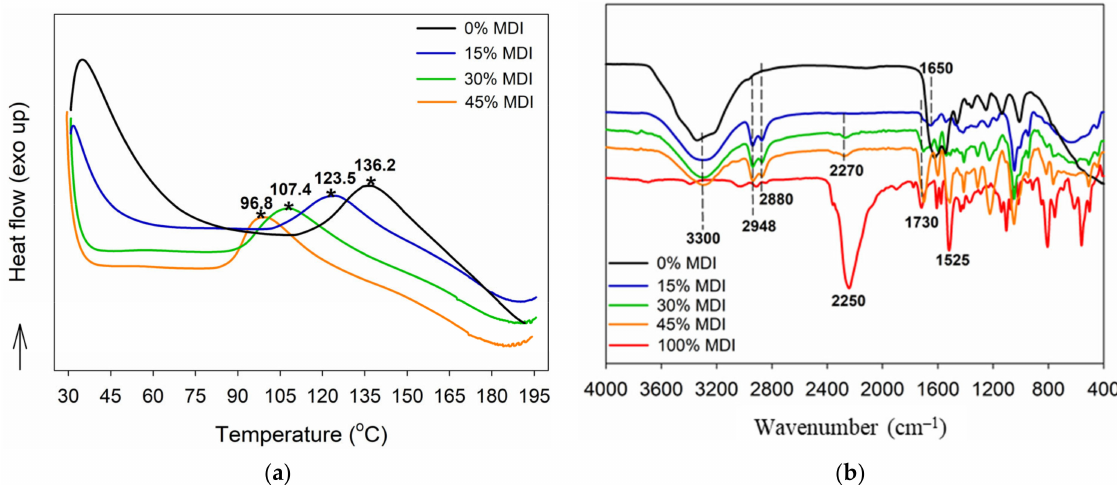
Figure 1. Characteristics of the UF resin and the UF/MDI hybrid adhesives ( a ) DSC thermogram of the hybrid adhesives and ( b ) ATR-FTIR spectra of the hybrid adhesives.